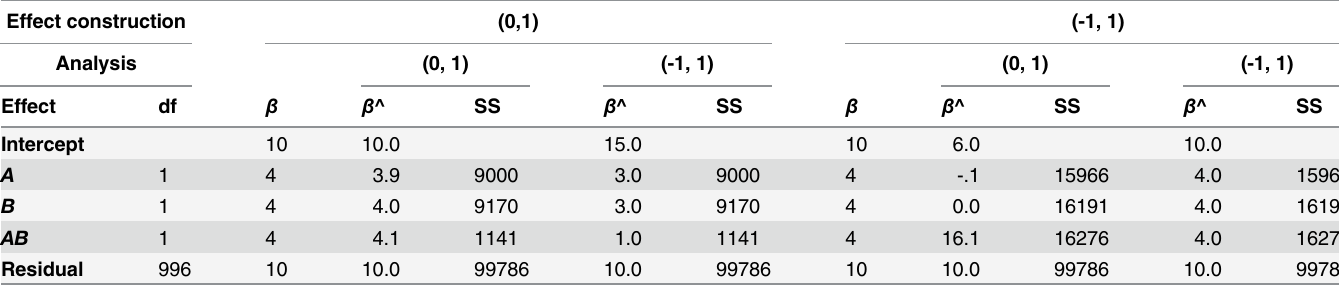
Table 4. Congruous and incongruous data